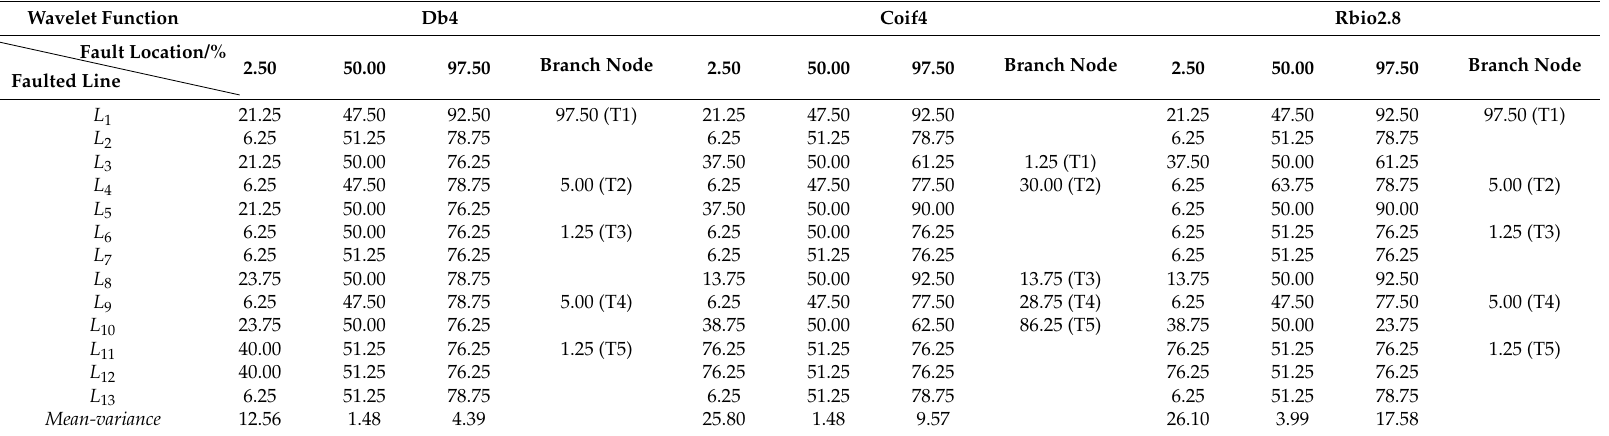
Table 4. Results of different fault location for different fault lines based on different sampling frequencies. Wavelet Function Db4 Coif4 Rbio2.8 Fault Location/% Faulted Line